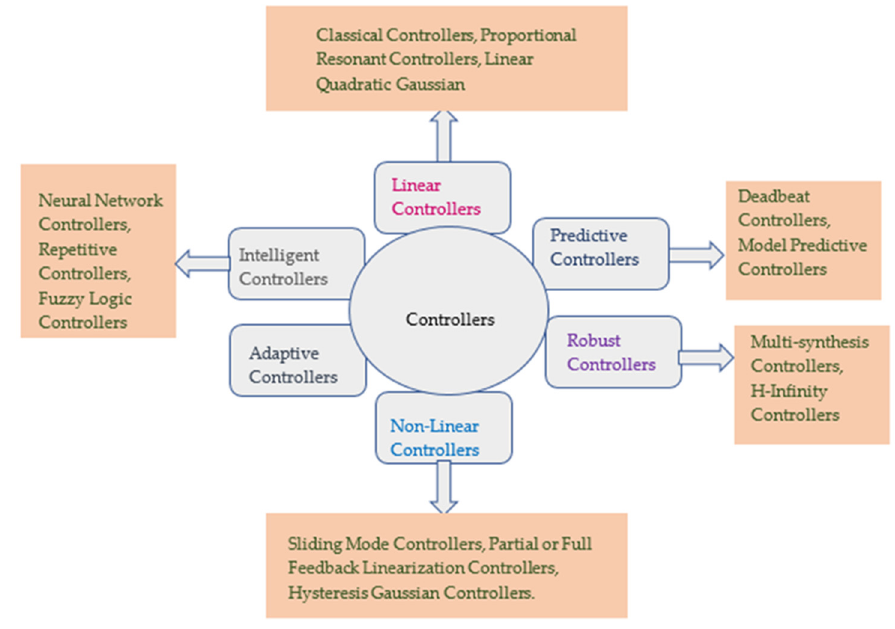
Figure 8. Classification of controllers used in grid-tied inverters.